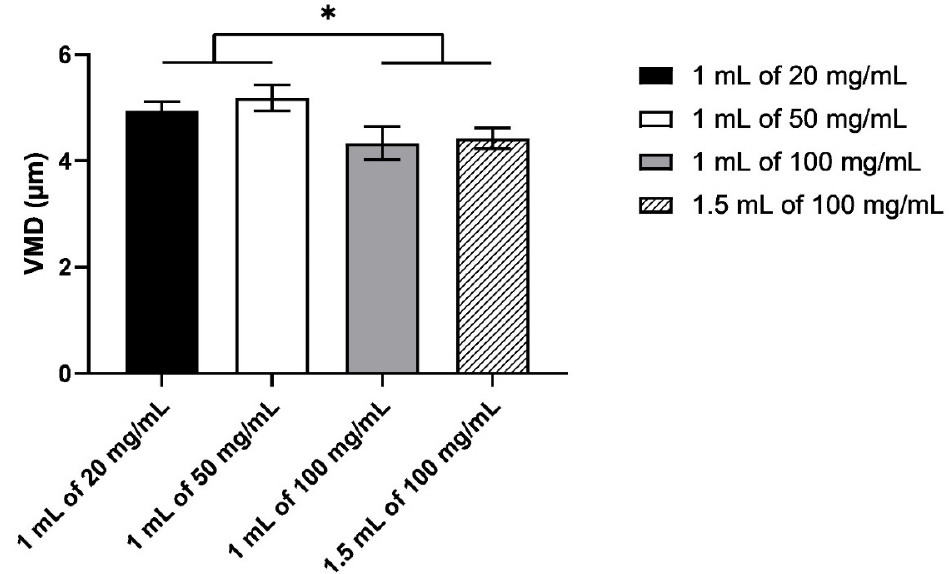
Figure 5. The geometric standard deviation of the droplets measured by laser diffraction. Data presented as mean ± stand- ard deviation ( n = 9). Statistical difference indicated by * ( p < 0.05). The percentage of aerosol sample by volume under 1, 2, 3, 5, and 10 µm is shown in Figure 6. About 50–60% of the aerosols was <5 µm. The nebulisers produced minimal sub- micron droplets at all concentrations/volumes, but the 100 mg/mL solution consistently produced more droplets by volume than 20 and 50 mg/mL at all cutoff diameters. In other words, the droplets from the 100 mg/mL solution were smaller than those from the other